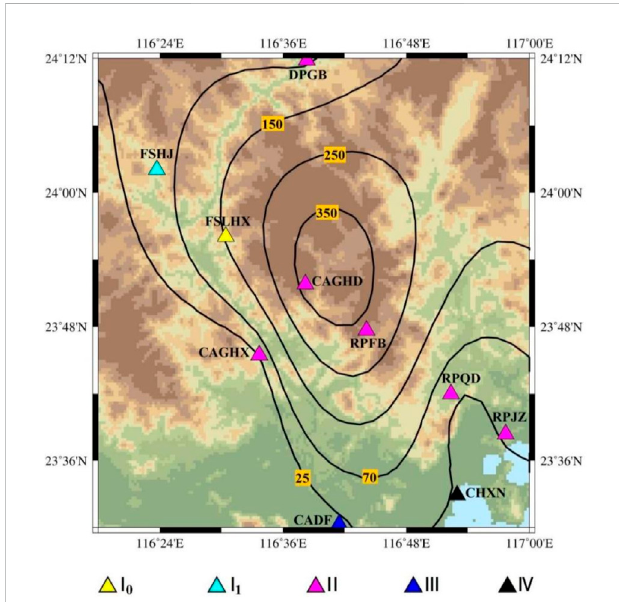
FIGURE 10 Geological conditions and elevation distribution of the stations. Yellow, cyan, pink, blue and black triangles represent sites classi fi ed as Class- Ⅰ 0 , Class- Ⅰ 1 , Class- Ⅱ , Class- Ⅲ , and Class- Ⅳ , respectively. The solid black lines indicate the elevation contour